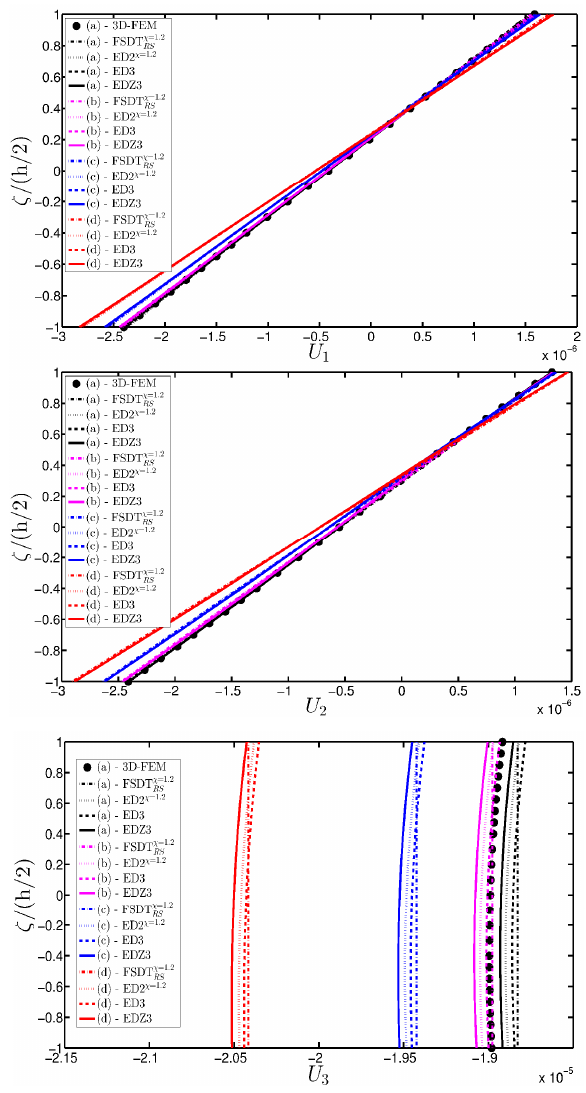
Figure 19. Through-the-thickness profiles of displacement components [m] for the CCCC laminated square plate with   45 / 0 / 45  as stacking sequence computed at the point A for different HSDTs. square plate with ( − 45/0/45 ) as stacking sequence computed at the point A for different HSDTs. The effect of the damage is investigated by varying the parameters of the function